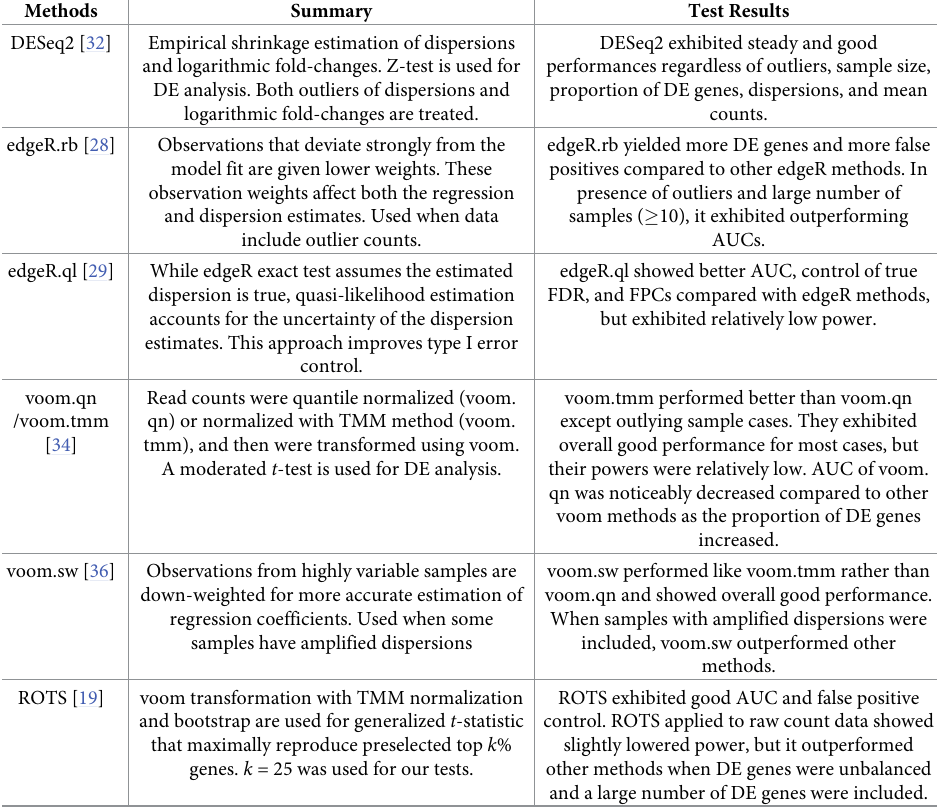
Table 1. Summary and test results of recently developed